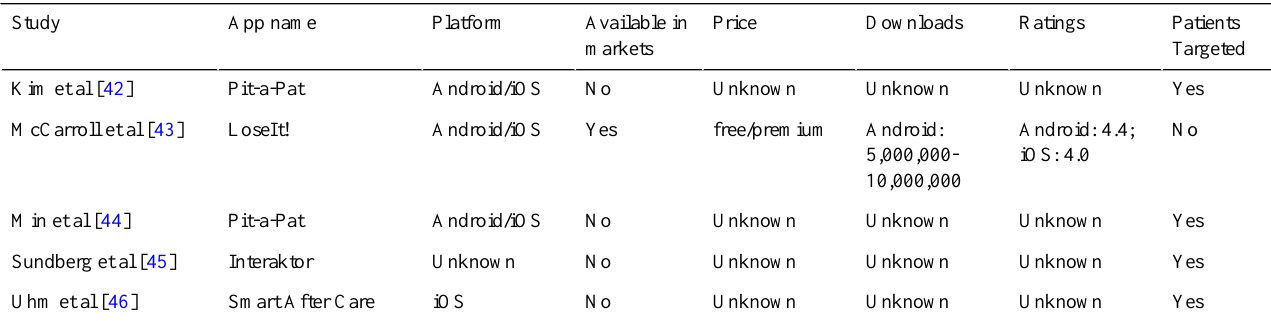
Table 3. Technological characteristics of included studies